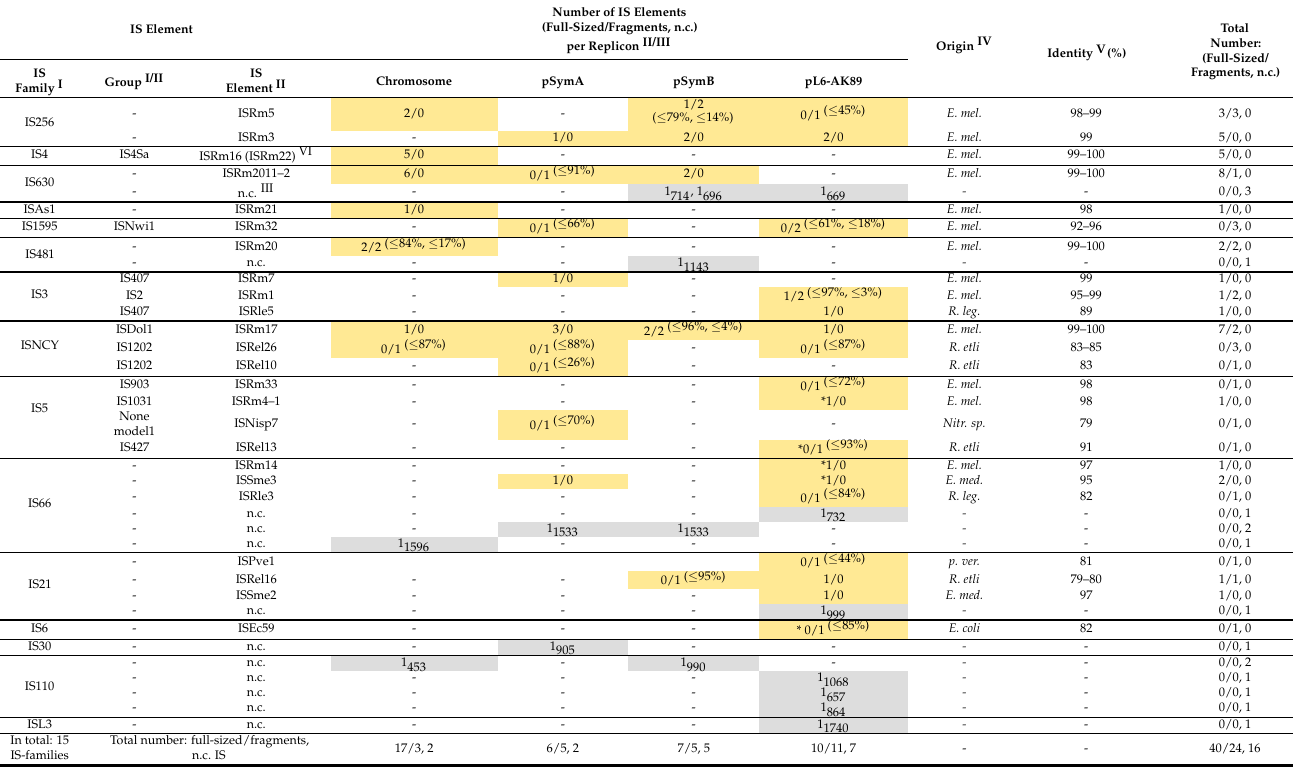
I Determined with digIS. II IS elements determined according to ISfinder (yellow squares), sequences characterized as mobile element by digIS but did not have significant alignments in ISfinder database (unclear IS